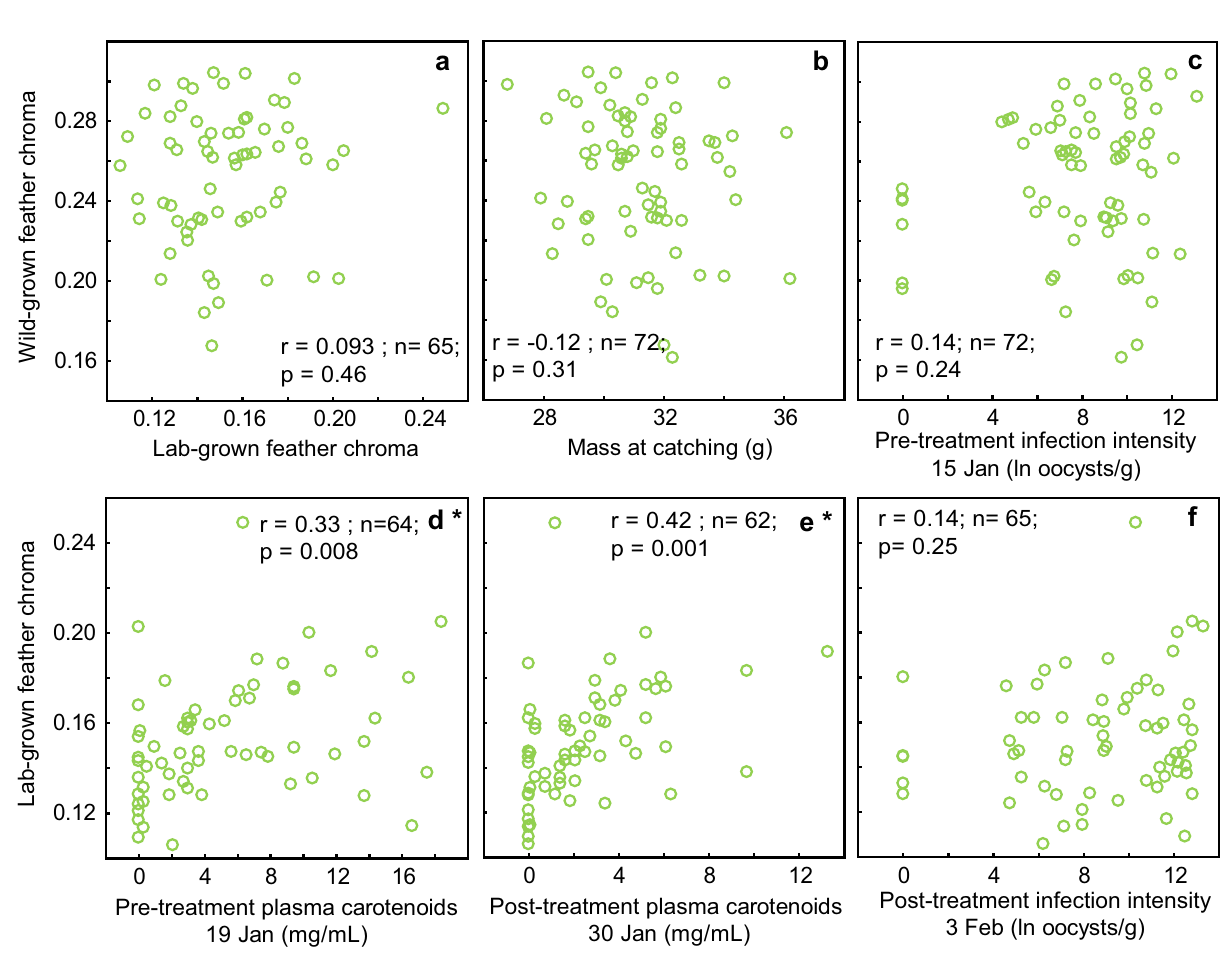
Figure 4. Correlations between feather chroma and physiological and phenotypical traits. Asterisks after the panel letter indicate significant